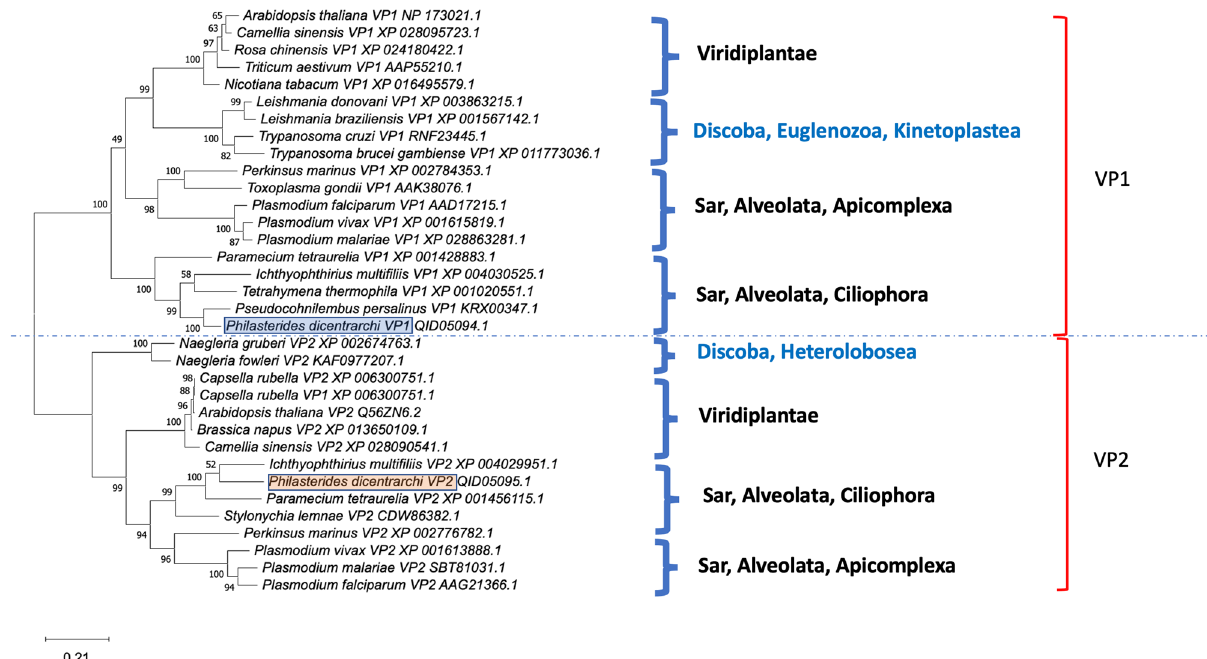
Figure 5. Phylogenetic analysis of aa sequences of P. dicentrarchi isoenzymes PdVP1 and PdVP2 inferred by Maximum likelihood method and JTT matrix-based model. The GenBank access number and the type of H + - PPase (vacuolar pyrophosphatase type 1 and 2, VP1-VP2) is included after the name of the species. The tree with the highest log likelihood (− 21,198.33) is shown. The percentage of replicate trees in which the associated taxa clustered together in the bootstrap test (500 replicates) is shown beside the branches. Initial trees for the heuristic search were obtained automatically by applying Neighbour-Join and BioNJ algorithms to a matrix of pairwise distances estimated using a JTT model and then selecting the topology with the highest log likelihood value. The tree shown is drawn to scale, with branch lengths measured in the number of substitutions per site. All positions containing gaps and missing data were eliminated using the TrimAl program. This analysis involved 34 amino acid sequences and a total of 621 positions in the final data set. Evolutionary analyses were conducted with MEGA X